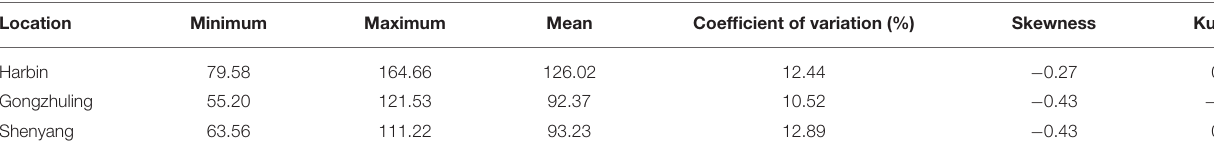
TABLE 1 | Statistical analysis and variation of total soluble sugar content of association panel. Location